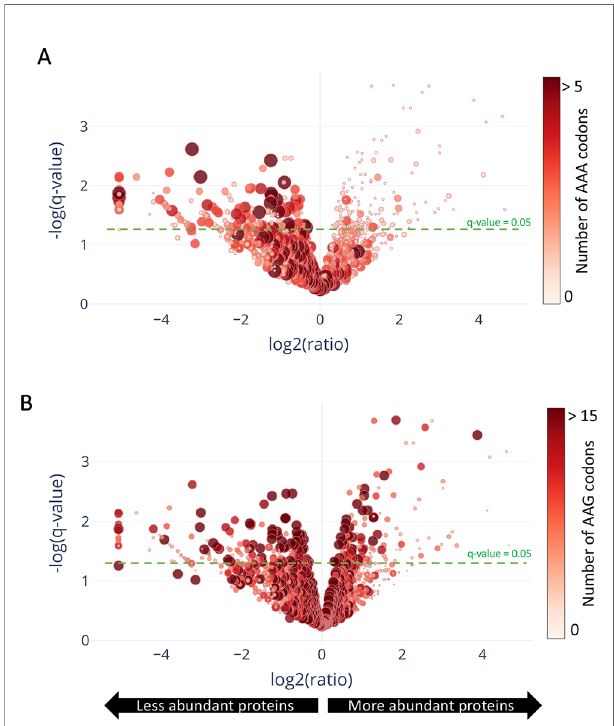
FIGURE 5 | Translation of proteins rich in lysine AAA codons is reduced upon MazF-ms expression. (A – B) Volcano plot showing differentially translated proteins (circles) detected by quantitative mass spectrometry and their AAA (A) or AAG (B) codon content. M. smegmatis cultures expressing MazF-ms for 4.5 h were incubated with azidohomoalanine (AHA) to label only newly synthesized proteins after toxin expression. The color saturation and circle size are proportional to the number of AAA (A) or AAG (B) codons in the